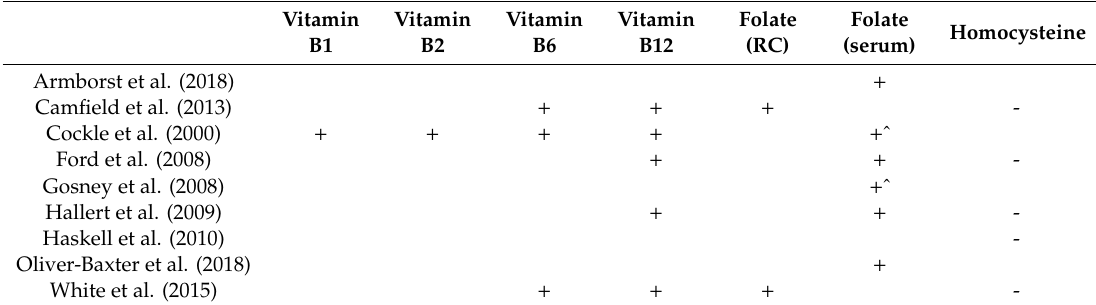
Table 5. Change in biomarkers in response to